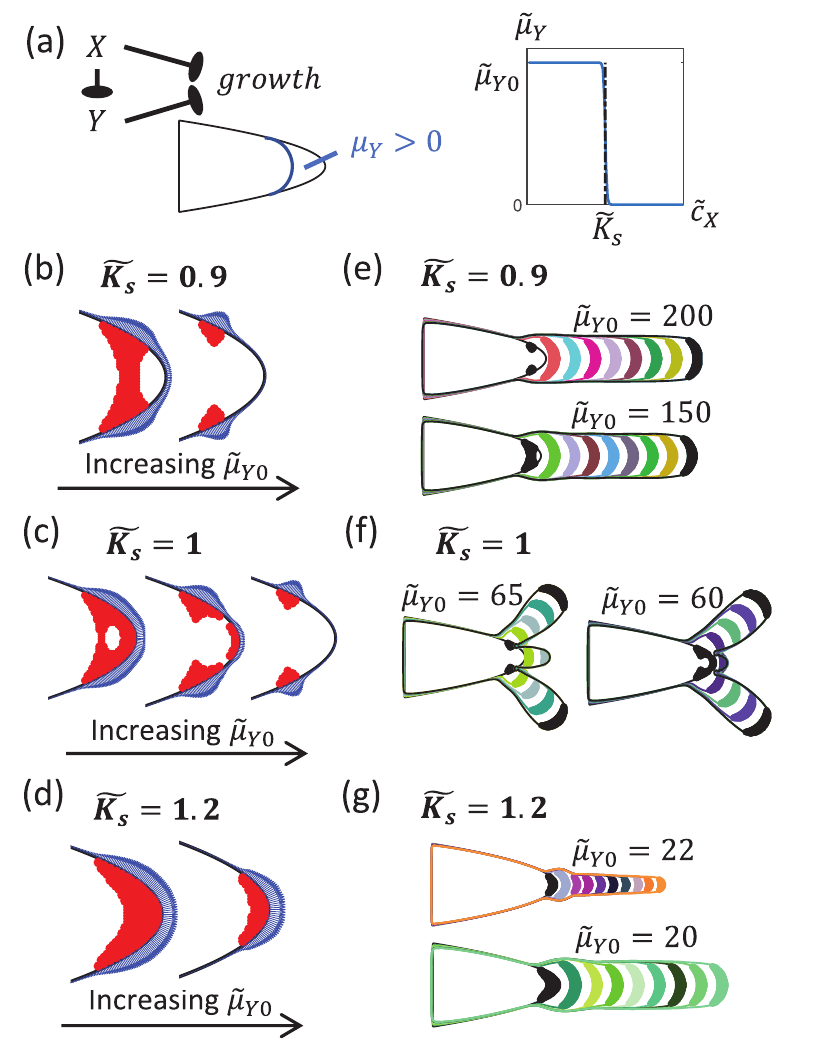
Fig 4. Dynamics of cluster when cells secrete two growth inhibitors. (a) We consider here the case where both X and ð ~ c Þ is a threshold Y inhibits growth. In addition, X also inhibits the production of Y , such that its secretion rate ~ m Y X function with Y only produced near the tip of the cluster where ~ c < ~ K . (b-d) The initial shape of the growth zone (in X s red) depends on the values of secretion threshold ~ K and ~ m through concentration profile of Y (S4 Fig). The blue s Y regions consist of arrows perpendicular to the tissue boundary, with the length of the arrows proportional to the boundary velocity at that point. (b) When ~ K ¼ 0 : 9 , the region of the growth zone closer to the tissue tip stops growing s is increased (left: ~ m ¼ 150 , right: ~ m ¼ 200 ). (c) When ~ K ¼ 1 , growth zone depletes from its center as first as ~ m Y 0 Y 0 Y 0 s ~ m increases (left: ~ m ¼ 56 , middle: ~ m ¼ 60 , right: ~ m ¼ 65 ). (d) When the ratio of secretion threshold to growth Y 0 Y 0 Y 0 Y 0 threshold ~ K ¼ 1 : 2 , the growth zone shrinks from the left boundary as ~ m increases (left: ~ m ¼ 20 , right: ~ m ¼ 22 ). s Y 0 Y 0 Y 0 The growth zone therefore remains attached to the tip of the tissue. (e-g) Cluster dynamics for the different values of ~ K , with the different colored regions representing the growth zones at different time points (colors randomly s generated). (e) When ~ K ¼ 0 : 9 , the cluster grows a single rod-like protrusion even though there are initially multiple s ¼ 1 , cluster can grow multiple protrusions (S5 Fig). (g) When ~ K ¼ 1 : 2 , there is only a growth regions. (f) When ~ K s s single growth zone and hence a single protrusion. [Other dimensionless parameters: ~ m ¼ 8 , γ r = X